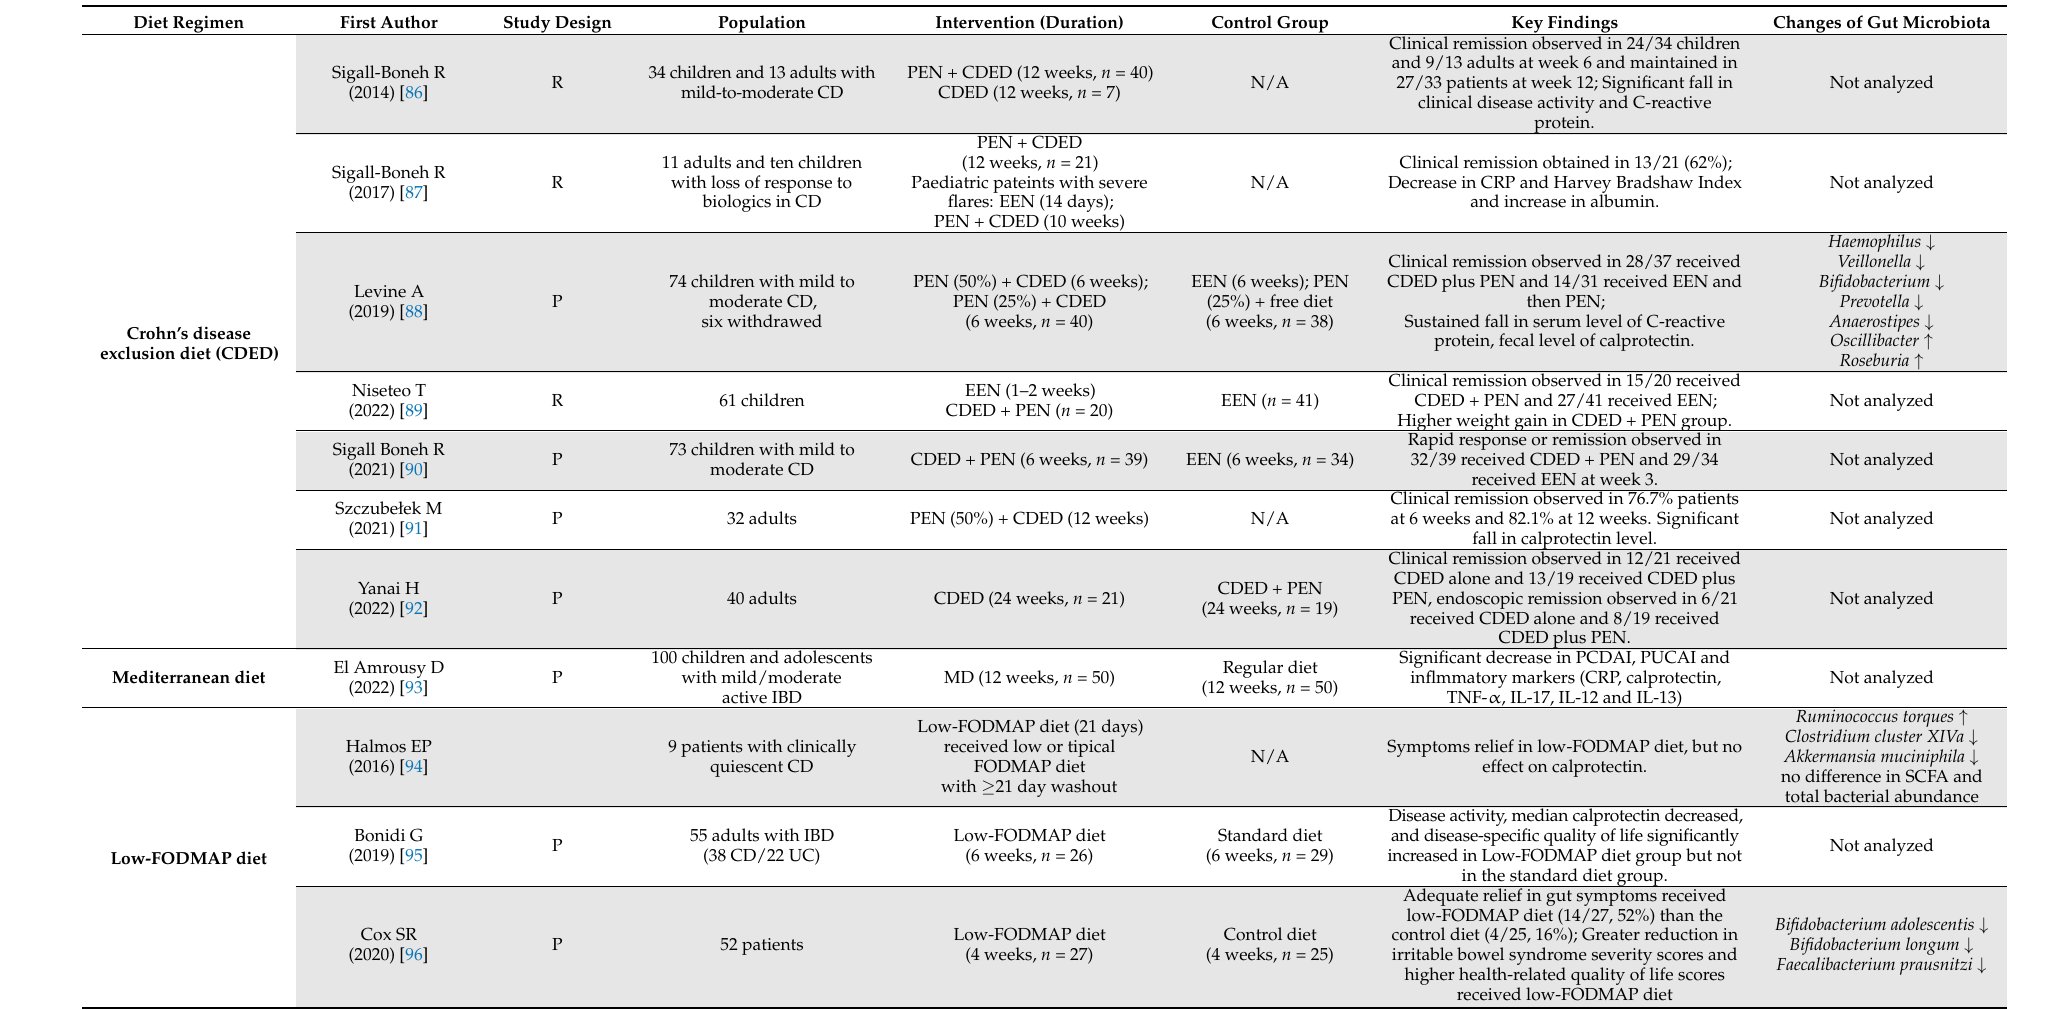
Table 2. Studies on diet strategies alleviating inflammatory bowel